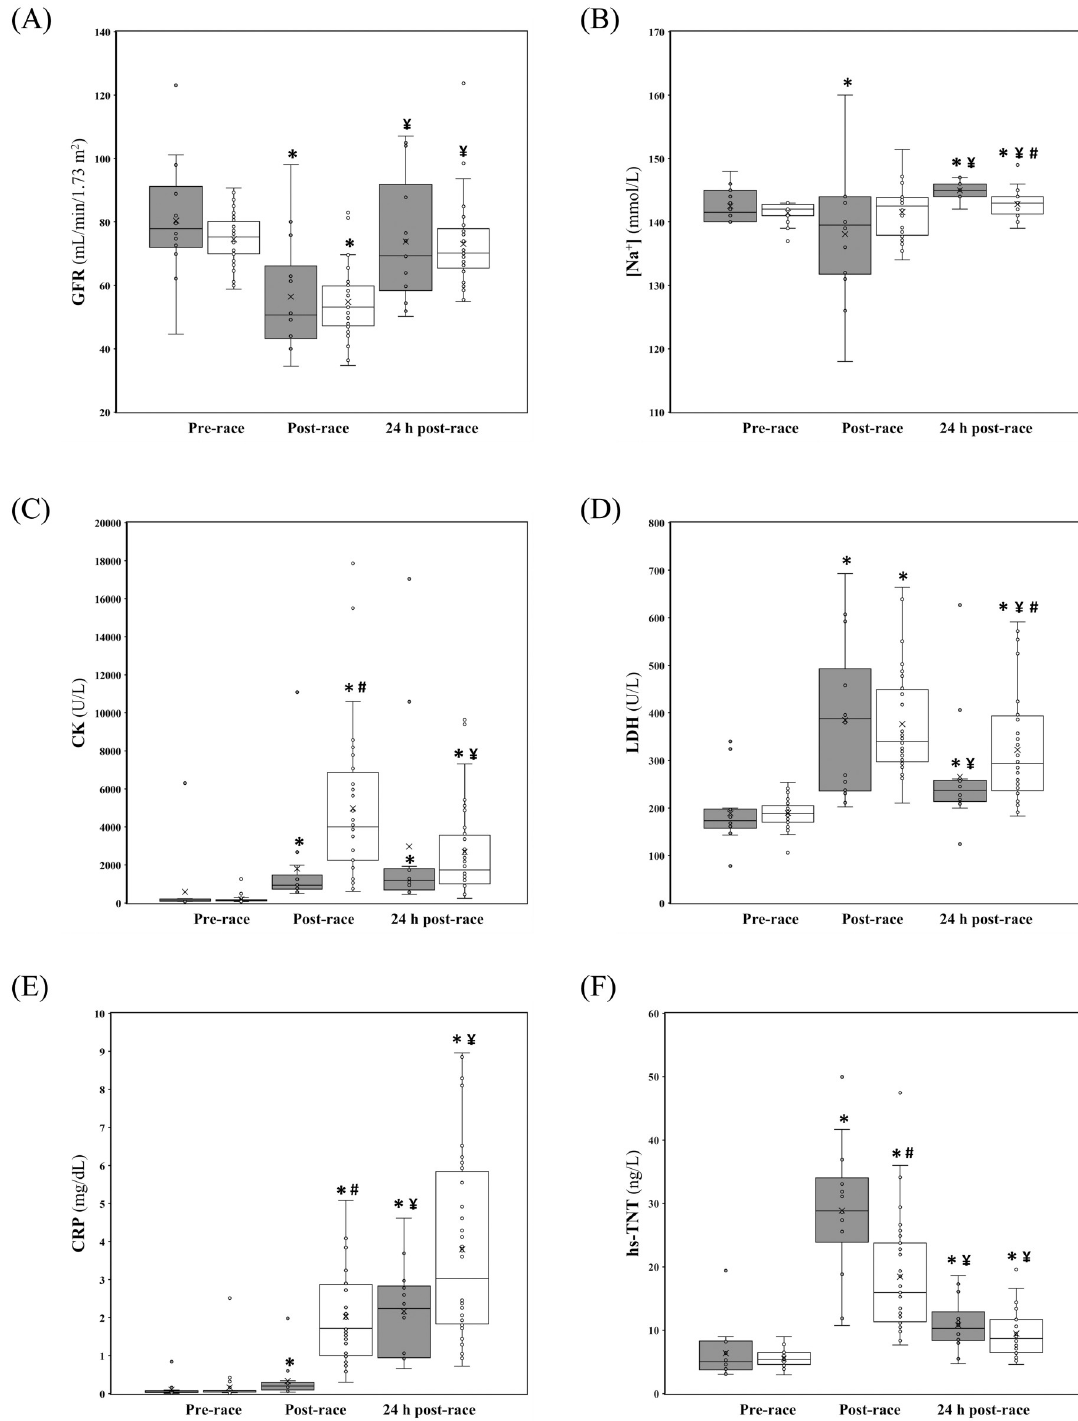
Fig 1. Glomerular filtration rate (panel A), sodium (panel B), creatine kinase (panel C), lactate dehydrogenase (panel D), C- reactive protein (panel E) and high sensitivity cardiac troponin (panel F) evolution from pre-race to 24-h post race in Long Trail runners (grey boxes) and Ultra Trail runners (white boxes). � Significantly different from pre-race (p < 0.05). # Significantly different from Long Trail runners (p < 0.05). ¥ Significantly different from the preceding time point (p < 0.05).